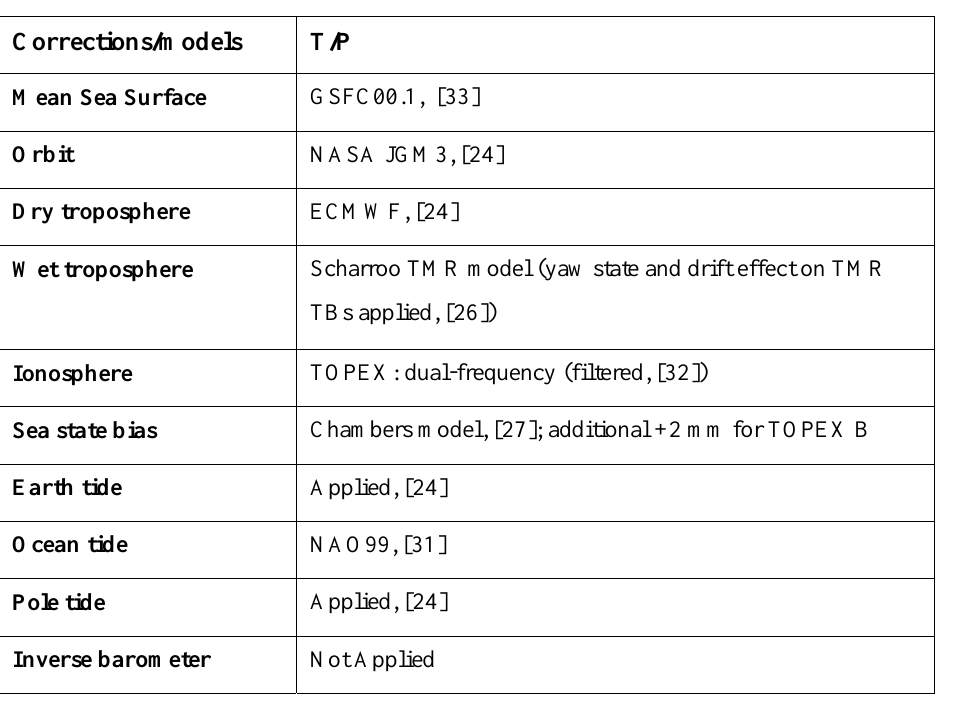
Table 1. Geophysical corrections and models used in the processing of TOPEX altimeter data